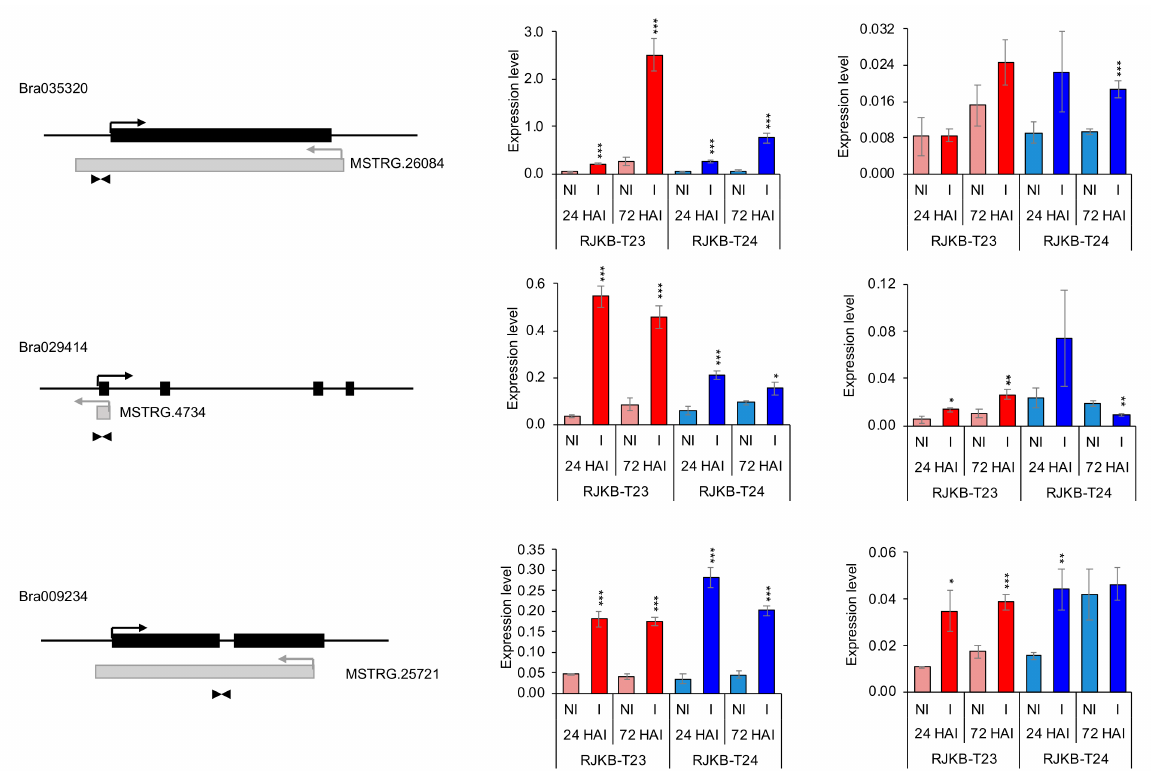
Figure 5. Expression levels in mRNAs and their paired NATs following F. oxysporum f. sp. conglutinans ( Foc ) inoculation. Black and gray boxes represent the exon regions of gene or NATs, respectively. Arrows represent the direction of transcription. Arrowheads represent the position of primer sets for qPCR to detect the NAT transcripts. Bar graph represents values that are means ± standard error (s.e.; three biological and technical replicates) of relative Bractin expression levels. *, p < 0.05; **, p < 0.01;